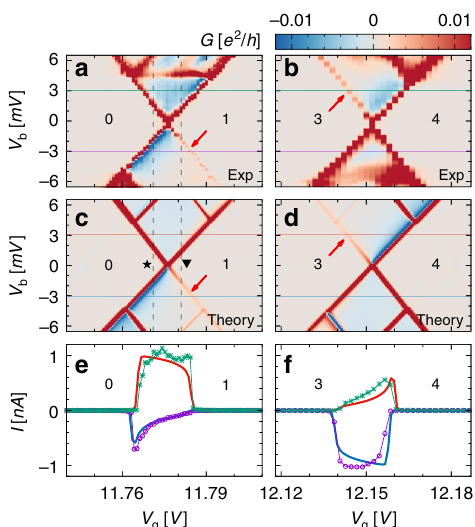
Fig. 3 Current suppression and particle-hole symmetry. a , b Experimental stability diagrams for shell 1. Current suppression features observed for single-electron tunneling in panel (b), also occur for single-hole tunneling under reverted bias polarity and mirroring of the gate voltage, as shown in panel ( b ). c , d Theoretical stability diagrams for the 0 ↔ 1 and 3 ↔ 4 dynamical regimes reproducing the experimental observation. e , f Comparison of experimental (data points with solid guiding lines) and numerical (solid lines) current-gate traces at bias voltage set to V b = ± 3.045 mV. The green and red (blue and purple) traces correspond to the positive (negative) bias voltage